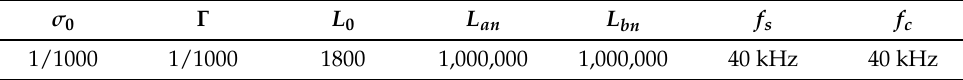
Table 1. System and control